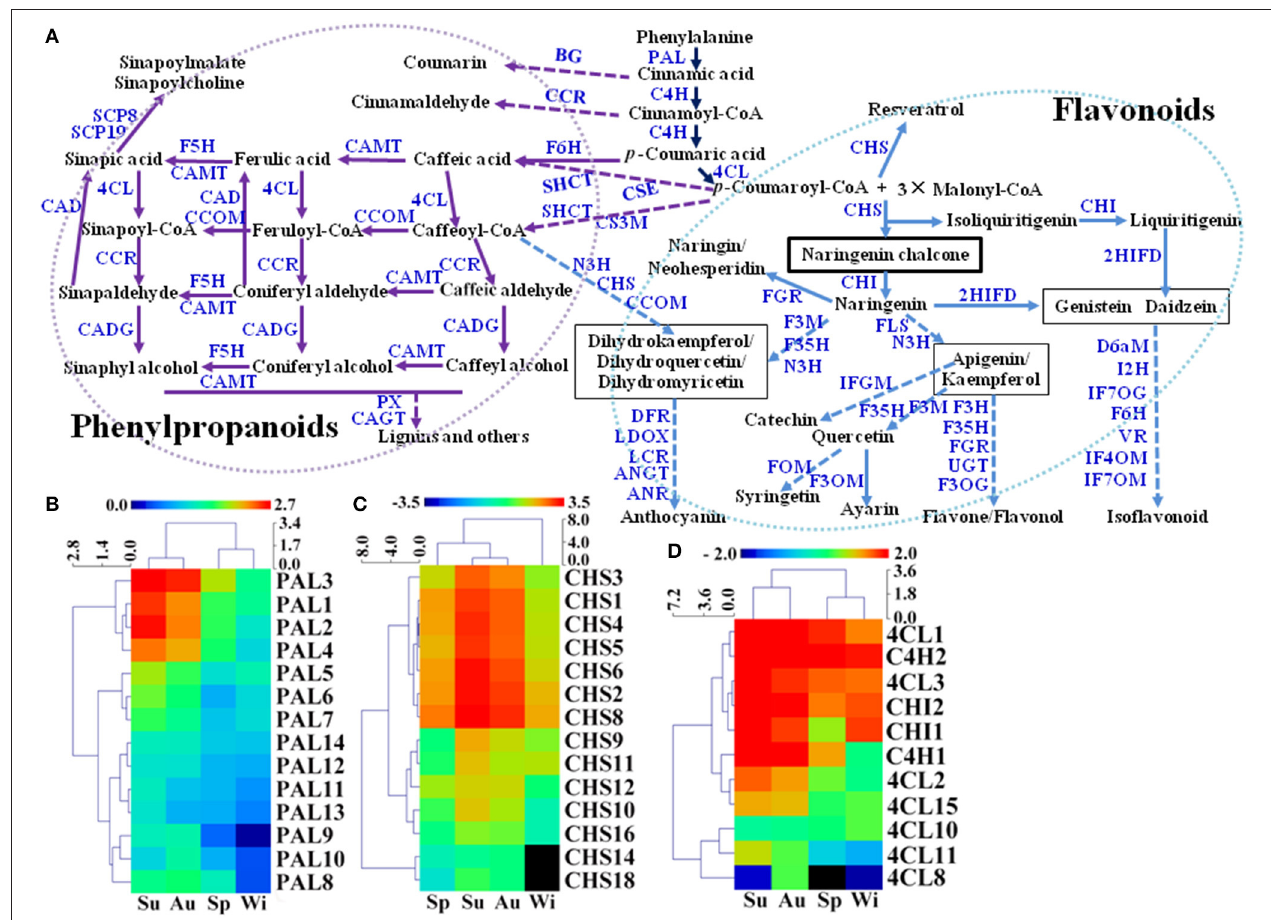
FIGURE 6 | Putative biosynthetic pathways of flavonoids and phenylpropanoids (FPs) (referring to KEGG pathways map00940 and map00941) in T. hemsleyanum FD-TRs (A) and heatmaps representing expression dynamics of genes involved in phenylalanine ammonia-lyases [PAL, (B) ], chalcone synthases [CHS, (C) ], 4-coumarate-CoA ligases (4CL), trans-cinnamate 4-monooxygenases (C4H), and chalcone isomerase [CHI, (D) ]. 4CL, 4-coumarate-CoA ligase; 2HIFD, 2-hydroxyisoflavanone dehydratase; ANGT, anthocyanidin 5,3-O-glucosyltransferase; ANR, anthocyanidin reductase; BG, beta-glucosidase; C4H, trans-cinnamate 4-monooxygenase; CAD, coniferyl-aldehyde dehydrogenase; CADG, cinnamyl-alcohol dehydrogenase; CAGT, coniferyl-alcohol glucosyltransferase; CAMT, caffeic acid 3-O-methyltransferase; CCOM, caffeoyl-CoA O-methyltransferase; CCR, cinnamoyl-CoA reductase; CHI, chalcone isomerase; CHS, chalcone synthase; CS3M, coumaroylquinate (coumaroylshikimate) 3 ′ -monooxygenase; CSE, caffeoylshikimate esterase; D6aM, 3,9-dihydroxypterocarpan 6a-monooxygenase; DFR, dihydroflavonol-4-reductase; F3M, flavonoid 3 ′ -monooxygenase; F3OG, flavonol 3-O-glucosyltransferase; F3OM, flavonol 3-O-methyltransferase; F35H, flavonoid 3 ′ , 5 ′ -hydroxylase; F5H, ferulate-5-hydroxylase; F6H, flavonoid 6-hydroxylase; FGR, flavanone 7-O-glucoside 2 ′′ -O-beta-L-rhamnosyltransferase; FLS, flavonol synthase; FOM, flavonoid O-methyltransferase; I2H, isoflavone 2 ′ -hydroxylase; IF7OG, isoflavone 7-O-glucosyltransferase; IF7OM, isoflavone-7-O-methyltransferase; IF4OM, isoflavone 4-O-methyltransferase; IFGM, isoflavone 7-O-glucoside-6 ′ -O-malonyltransferase; N3H, naringenin 3-dioxygenase; LCR, leucoanthocyanidin reductase; LDOX, leucoanthocyanidin dioxygenase; PAL, phenylalanine ammonia-lyase; PX, peroxidase; SCP8, serine carboxypeptidase-like 8; SCP19, serine carboxypeptidase-like 19; SHCT, shikimate O-hydroxycinnamoyltransferase; UGT, UDP-glucosyl transferase; VR, vestitone